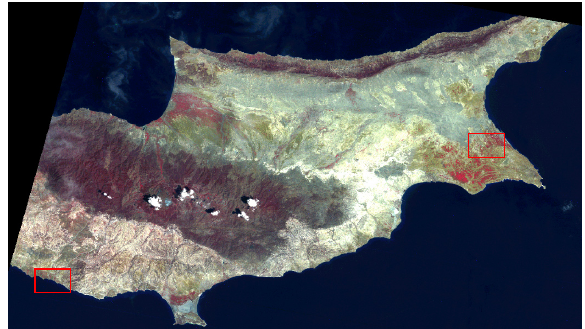
Fig 1. Landsat TM image of Cyprus: Mandria (left) and Kokkinochoria (right) area. Fig. 1. Landsat TM image of Cyprus: Mandria (left) and Kokkinochoria (right)